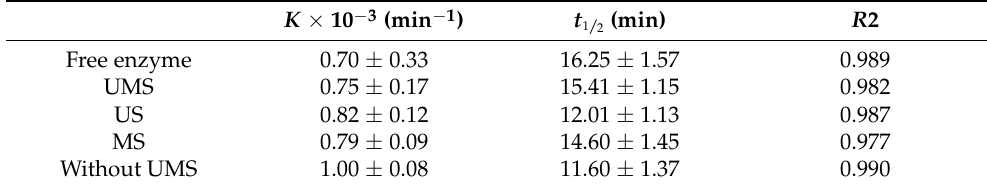
Table 2. Enzymatic deactivation parameters of the free enzyme and IE prepared with and without UMS